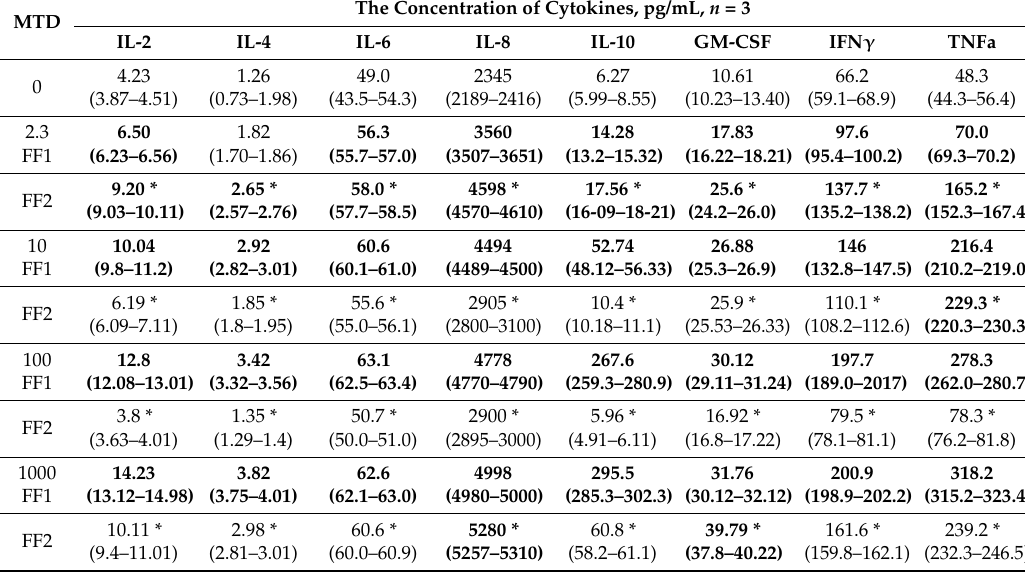
Table 3. The concentration of cytokines in supernatants of HBMLs after 24 h of co-cultivation with nanoparticles of iron oxides at various doses, Me